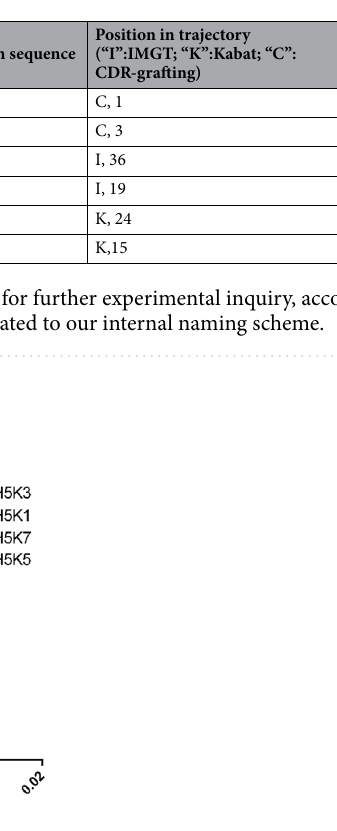
Figure 1. ELISA test performed to detect the activity of the four